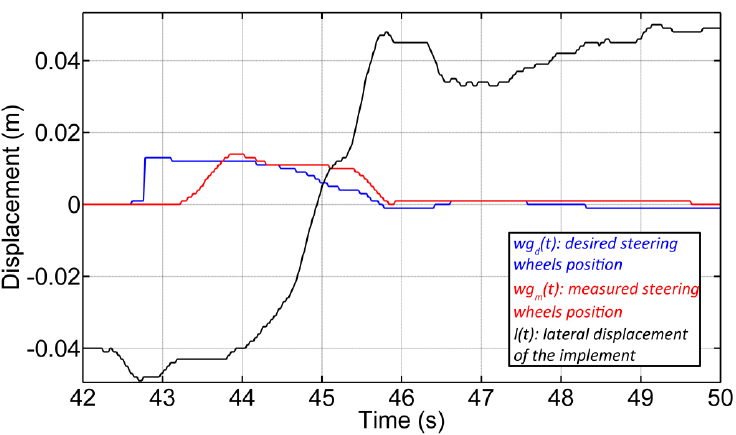
Figure 20. Time response of the two PID controllers.